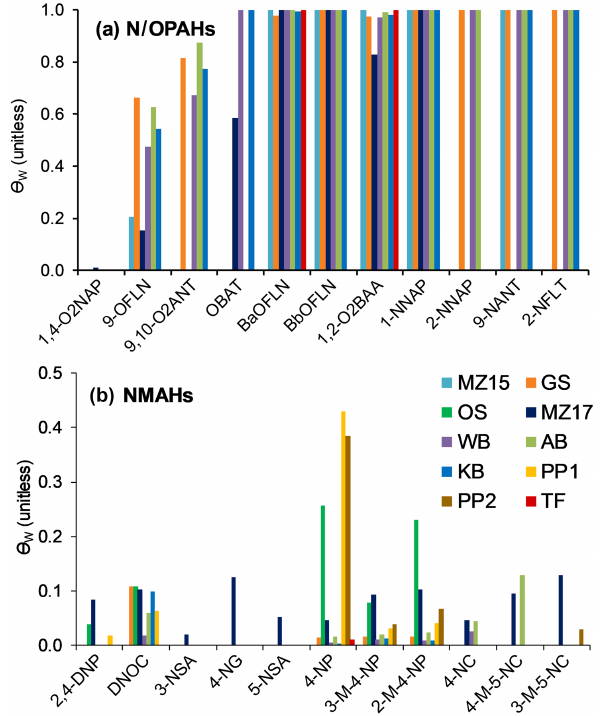
Figure 7. Fraction of N/OPAHs (a) and NMAHs (b) removed by particle scavenging ( θ w )